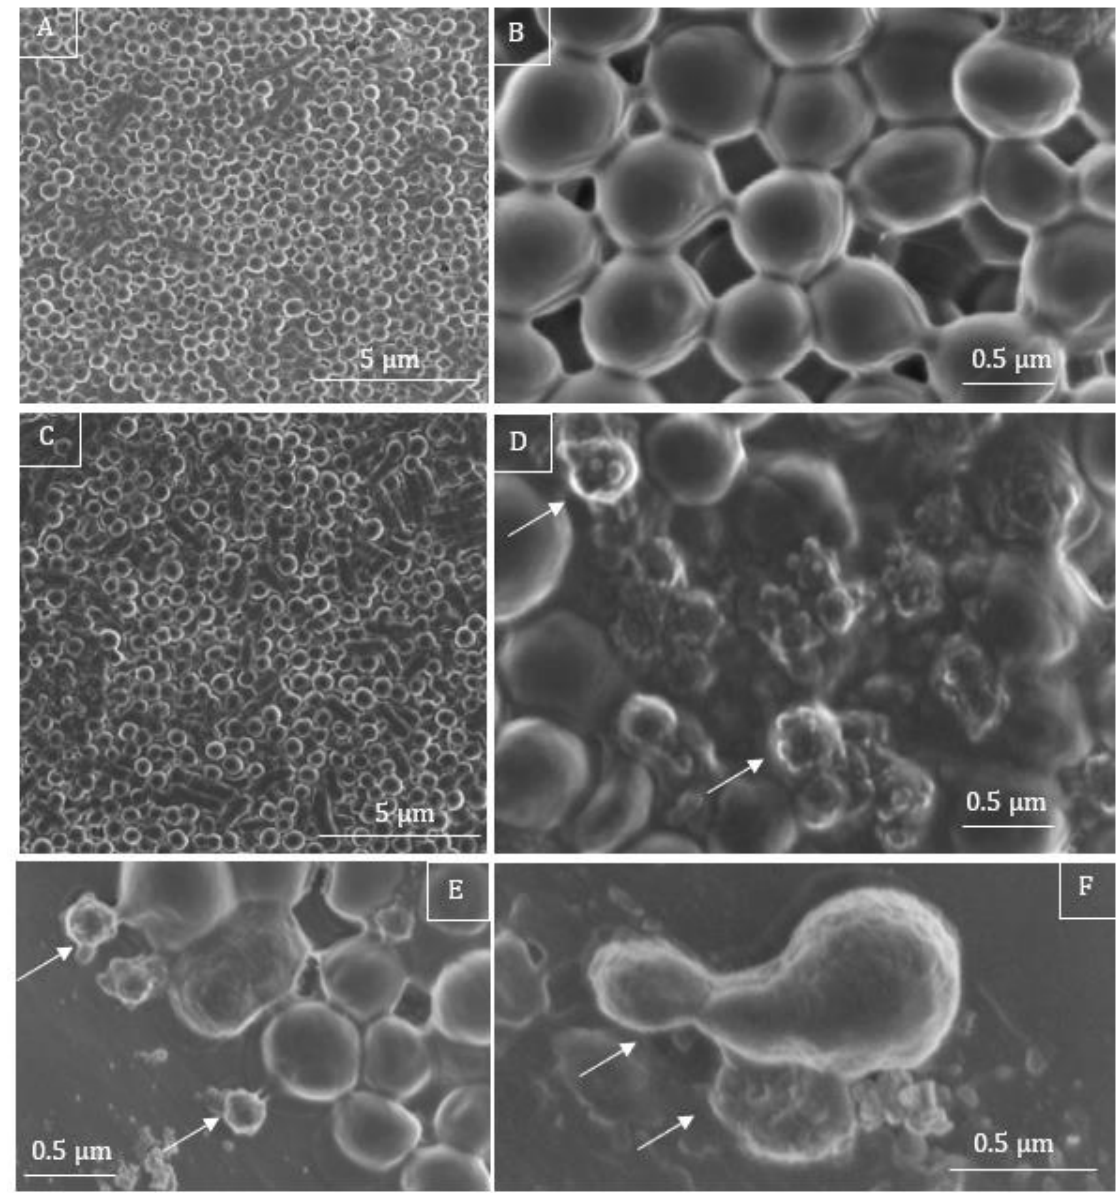
Figure 8. SEM micrographs of S. aureus . Untreated bacteria are round and intact ( A , B ). After treatment with C7 at a sub-MIC of 2 µg/mL bacteria present irregular shapes ( C , F ), partially irregular cellular surface ( D – F ), accompanied by burst cells and completely lysed cells are found, with damaged cell wall and caused the non-uniform distribution of cytoplasmic materials ( D – F ), white